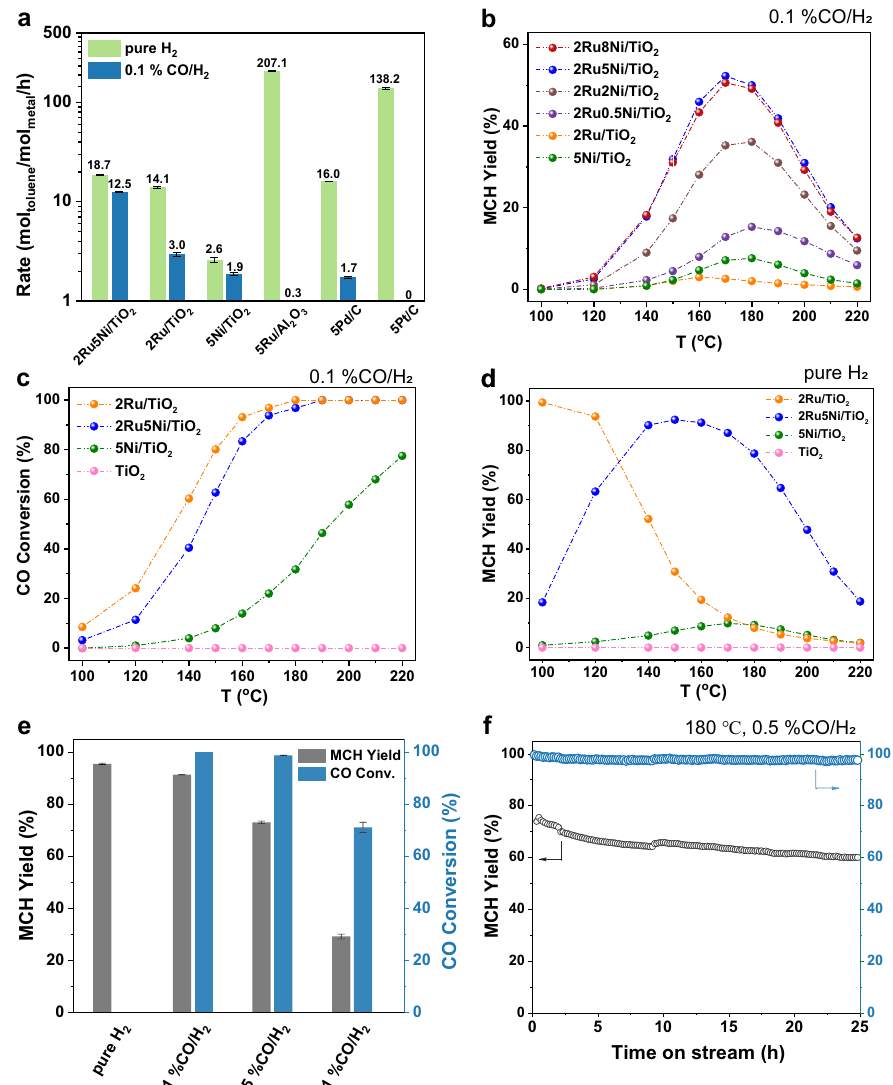
Fig. 1 | Toluene hydrogenation performance of catalysts under different con- ditions. a The metal-normalized toluene conversion rates at 170°C over different catalysts using either pure hydrogen or 0.1%CO/H 2 (CO:Ar:H 2 =0.1:0.1:99.8, v/v, GHSV (gas hourly space velocity)=36,000mL/g cat /h) as carrier gases. The con- version rates of toluene were measured in kinetic region (i.e., toluene conver- sion <15%). b MCH yields of different catalysts in 0.1% CO/H 2 carrier gas. c CO conversion of different catalysts in 0.1% CO / H 2 carrier gas with toluene. d MCH yields of different catalysts in pure hydrogen carrier gas. The measurements for